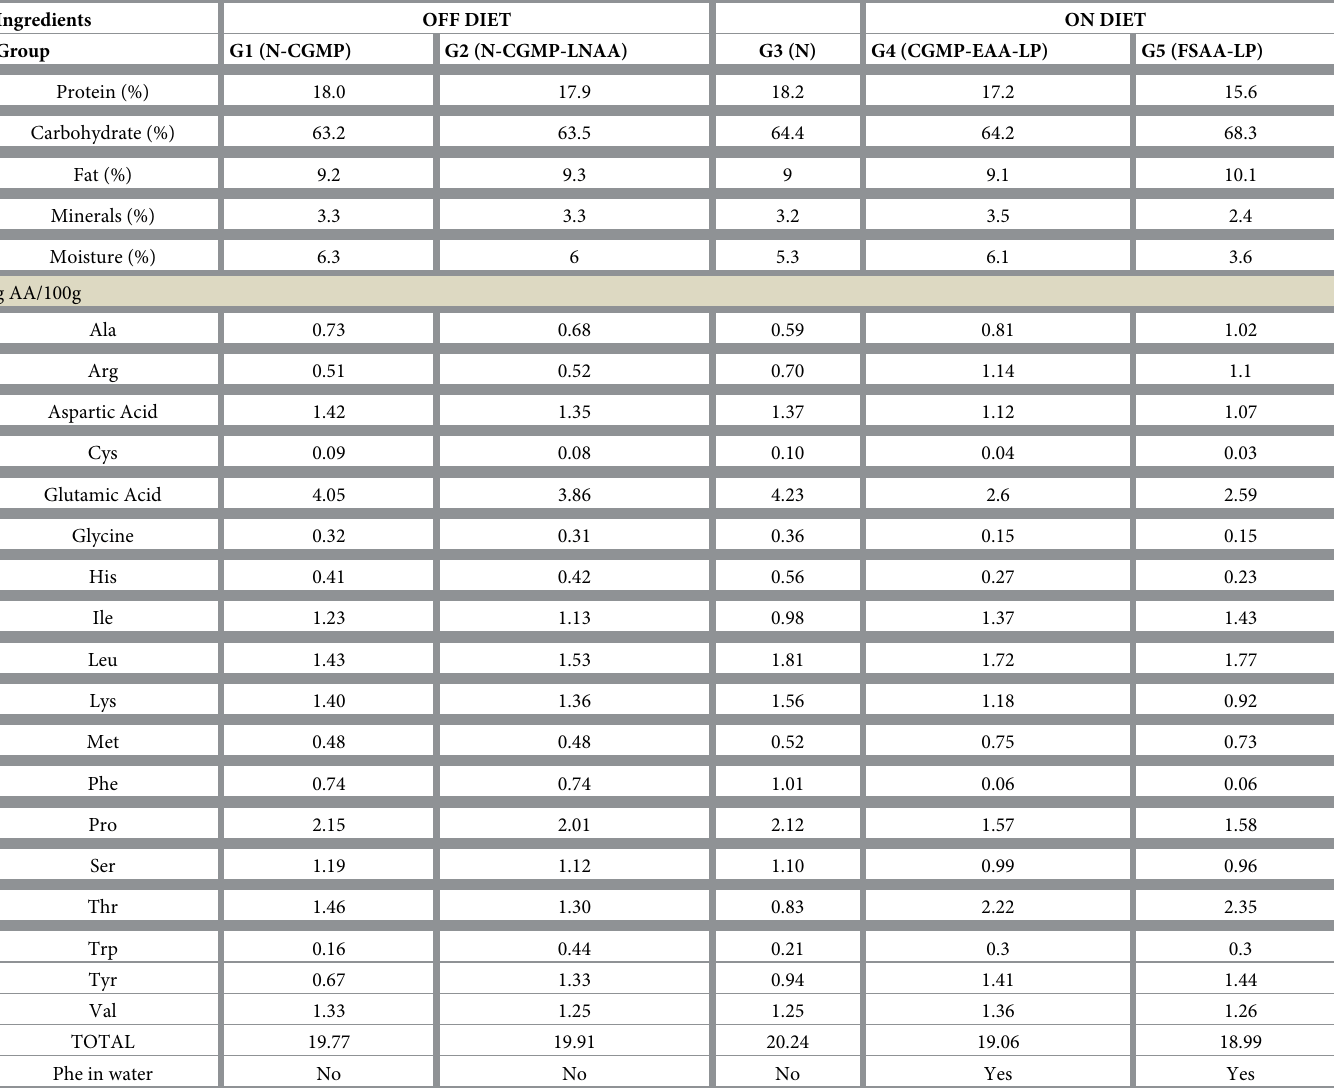
Table 2. Analysis of diets G1-G5. The diets G4 (CGMP-EAA-LP) and G5 (FSAA-LP) receive in addition Phe from the drinking water (0,563mg